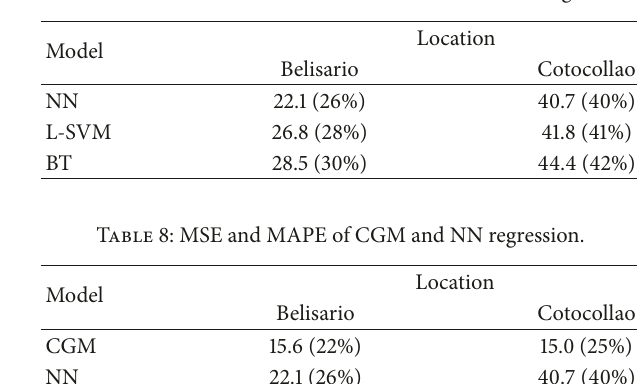
Table 7: MSE and MAPE of the NN, L-SVM, and BT on regression.